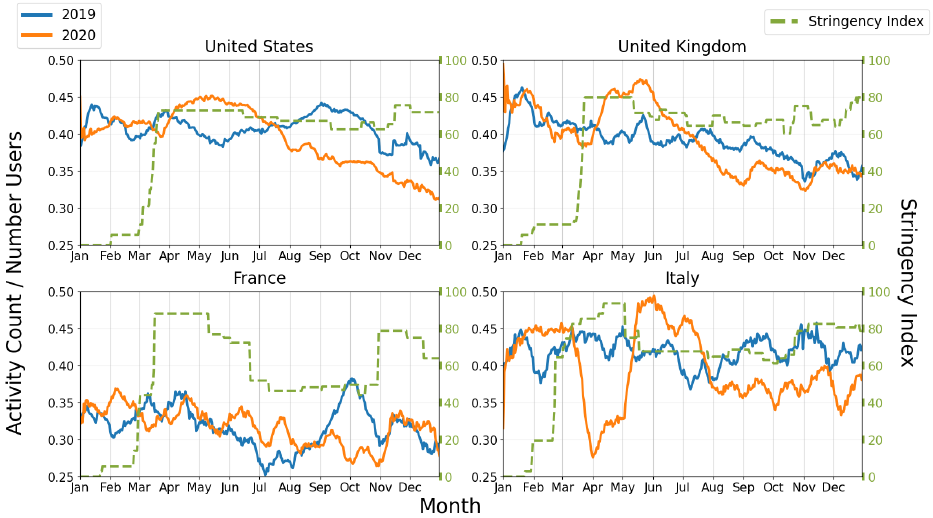
Figure 4. COVID-19 Government Response Stringency Index (GRSI) and daily activities counts per number of users in country using the controlled